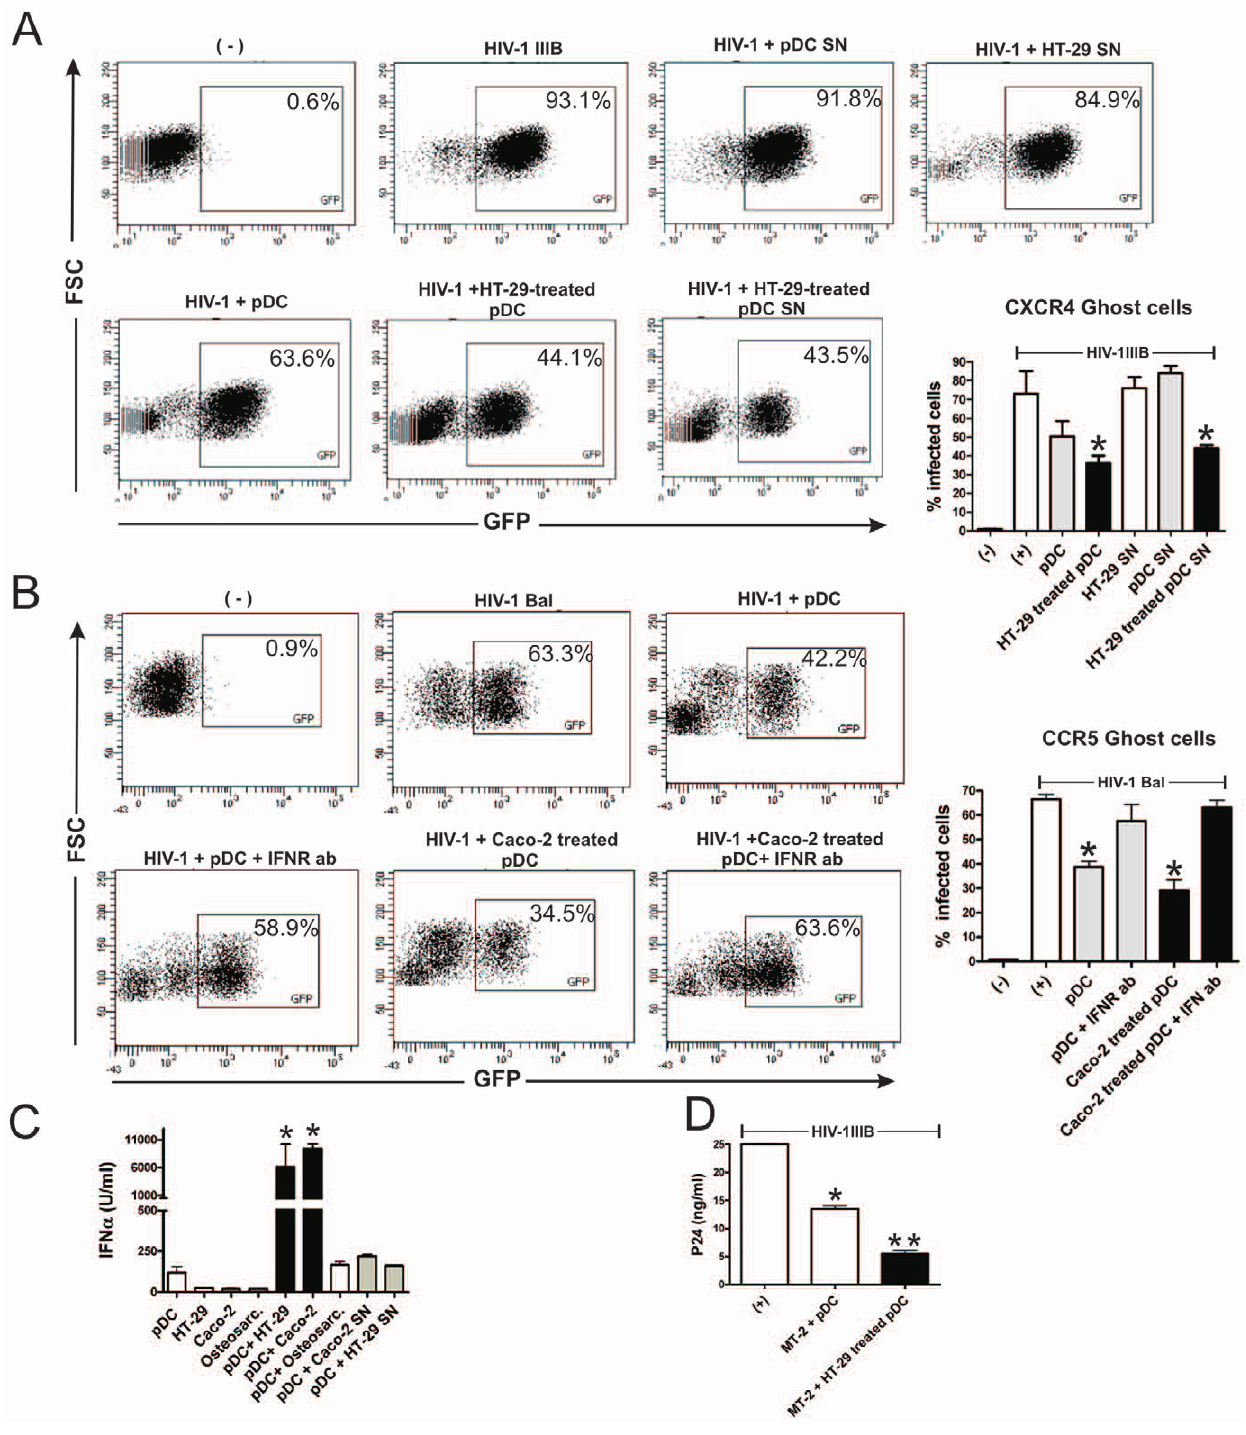
Figure 8. Epithelial cells improve the anti-HIV activity mediated by pDCs. ( A ) GHOST cells expressing CD4, CXCR4, and a Tat-dependent green fluorescent protein reporter cassette were cultured in 24-well flat bottom plates (5 6 10 4 cells/well) with or without HIV-1 IIIB (50 ng p24) for 2 h at 37 u C. Cells were then washed and incubated with 1 6 10 5 pDCs (untreated or preincubated with HT-29 cells for 12 h) or supernatants collected after 12 h of culture of pDCs, HT-29 confluent cells, or pDCs cultured together with HT-29 cells. After 48 h, the infection of GHOST cells was analyzed by flow cytometry by studying the percentage of GFP + cells. A representative experiment (n=4–5) is shown. Graph bars show the percentage of GHOST cells infected by HIV. Results are the mean 6 SEM of 4–5 experiments performed in duplicate. *p , 0.05 vs GHOST cells incubated only with HIV-1IIIB ( + ). ( B ) GHOST cells expressing CD4, CCR5, and a Tat-dependent green fluorescent protein reporter cassette were cultured in 24-well flat bottom plates (5 6 10 4 cells/well) with or without HIV-1 BaL (50 ng p24) for 2 h at 37 u C. Cells were then washed and incubated with 1 6 10 5 pDCs (untreated or preincubated with Caco-2 cells for 12 h). When indicated, a blocking antibody directed to type I IFN receptor (50 m g/ml) was added to the cultures before the addition of pDCs. After 48 h, the infection of GHOST cells was analyzed by flow cytometry by studying the percentage of GFP + cells. A